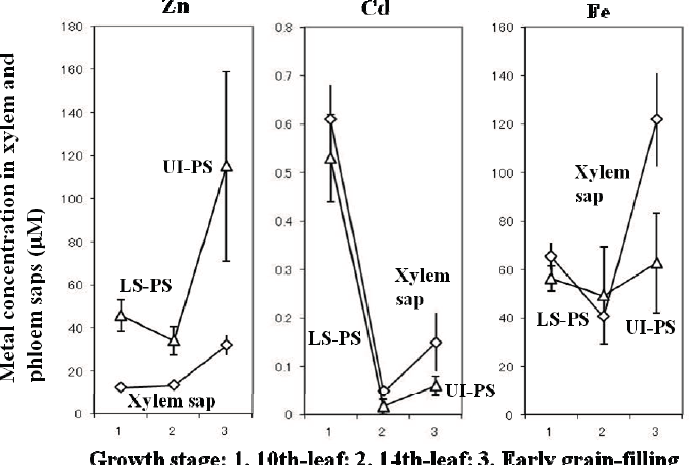
Figure 6. Metal concentrations in the xylem and phloem saps obtained from rice plants grown in a flooded Cd-contaminated soil. Phloem sap was collected from the leaf sheaths (LS-PS) of the 9th leaves at 10th-leaf stage and the 13th leaves at 14th-leaf stage, and from the uppermost internodes (UI-PS) at early grain-filling. Data are from Yoneyama et al. [55]. ◊ : metal concentrations in the xylem sap, Δ : metal concentrations in the phloem